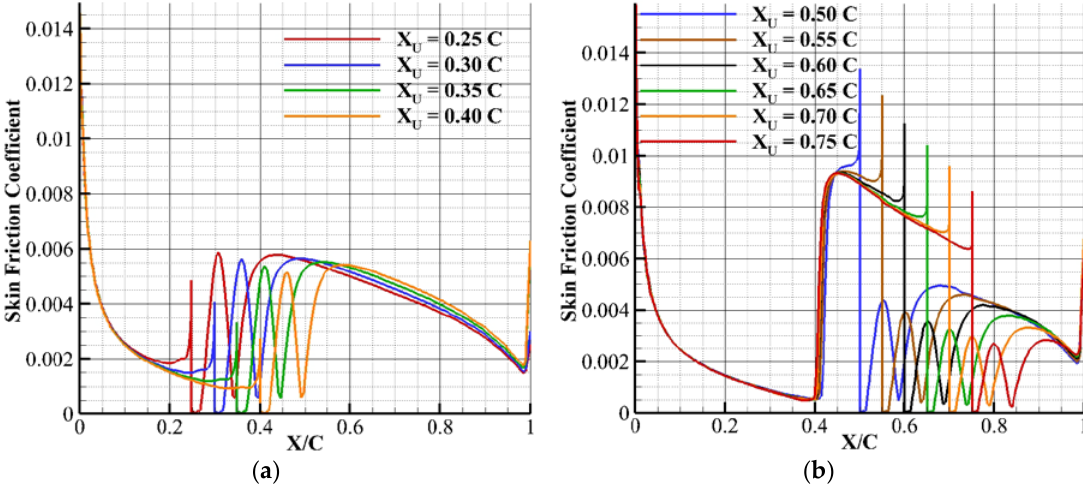
Figure 13. Skin friction coefficient values for airfoils with a step ( a ) before the viscous boundary layer transition point and ( b ) after the transition point ( Re = 5.9 × 10 6 and α = 2.5 ◦